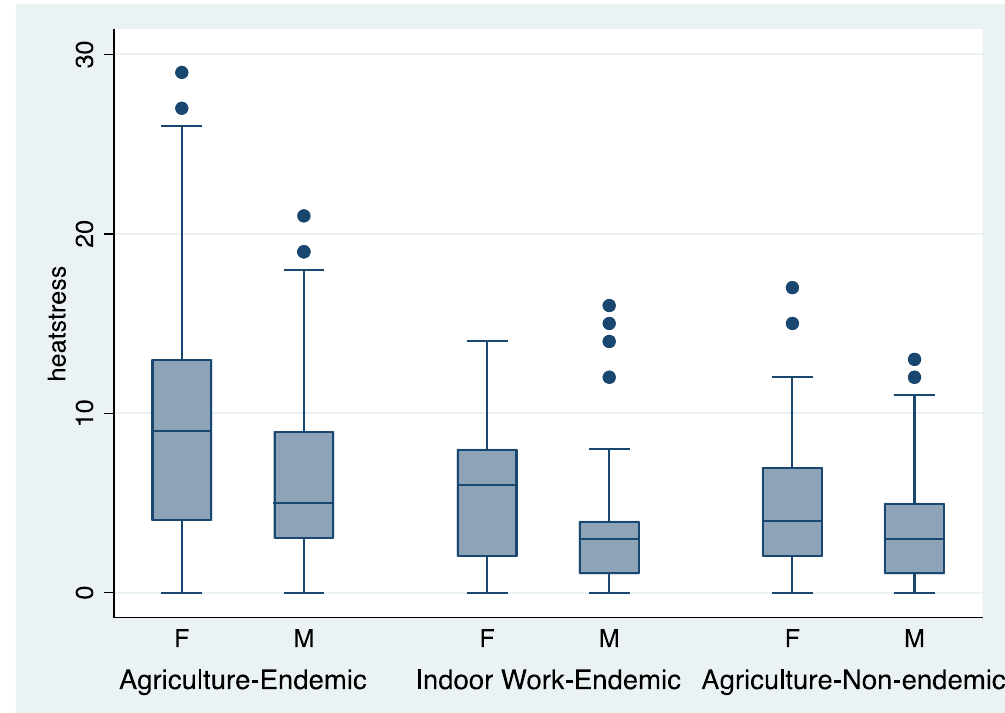
Figure 1. Box plots of the heat stress symptom index by region and gender. •- dots indicate extreme observations (>1.5 * interquartile range).